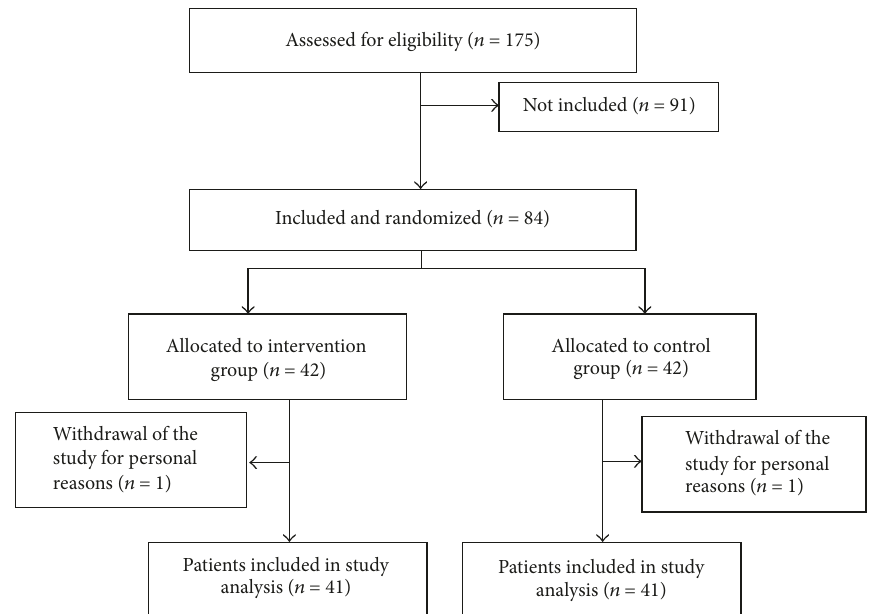
Figure 1: Flowchart of